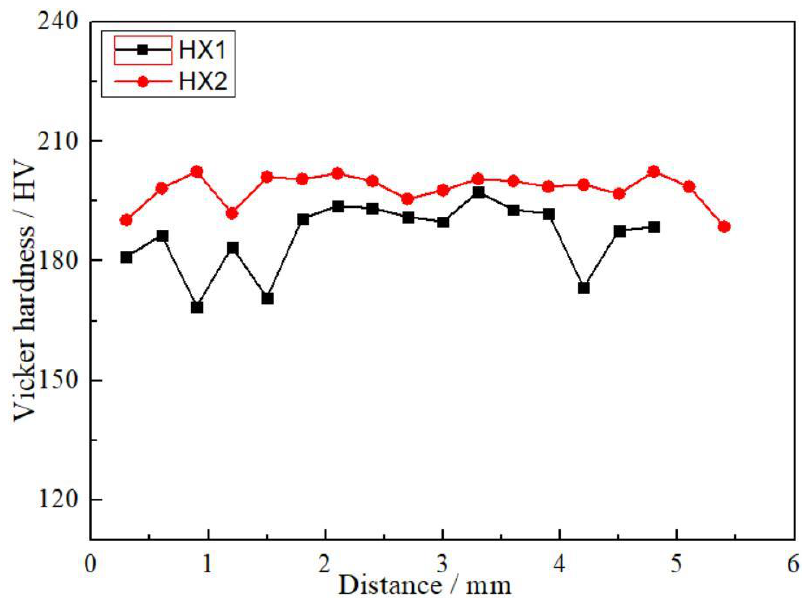
Figure 5. The surface hardness of the HX1 and HX2 coatings.